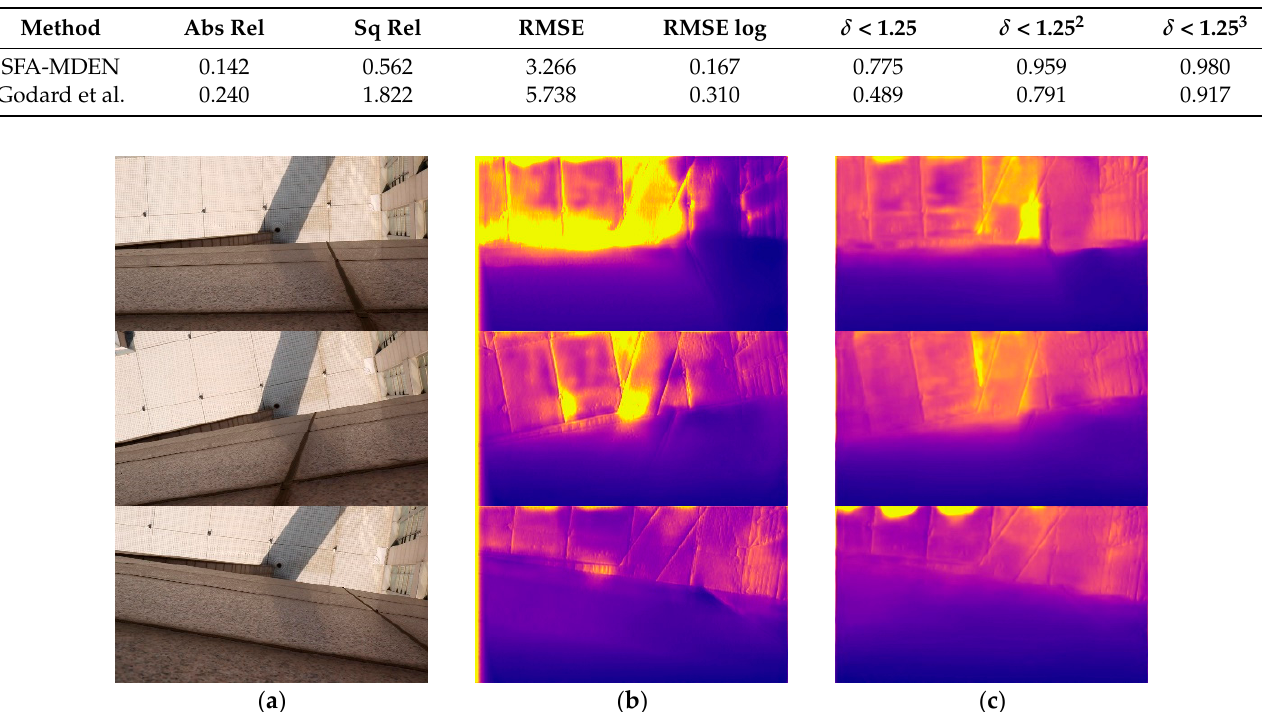
16 of 19 Figure 7. An image sample of the BHDE-v1 dataset. The area inside the red rectangle window is the sparsely depth-annotated plain land, while areas in the green window are not annotated. SFA-MDEN and the model from Godard et al. [29], which performs well on the Eigen split of KITTI, are tested without fine-tuning on the BHDE-v1 dataset. Table 5 presents the quantitative results and Figure 8 illustrates the qualitative samples. As can be seen, the precision metrics of our SFA-MDEN are superior to Godard et al. [29], with a depth range of about 20 m. Moreover, SFA-MDEN indicates stronger robustness to the shadows